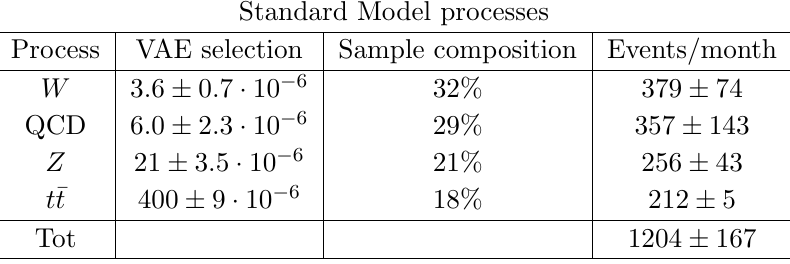
Table 3 . By-process acceptance rate for the anomaly detection algorithm described in the text, computed applying the threshold on Loss reco shown in (cid:12)gure 7. The threshold is tuned such that a fraction of about (cid:15) SM = 5 : 4 (cid:1) 10 (cid:0) 6 of SM events would be accepted, corresponding to (cid:24) 1000 SM events/month, assuming the LHC running conditions listed in section 1. The sample compo- sition refers to the subset of SM events accepted by the anomaly detection algorithm. All quoted uncertainties refer to 95% CL regions.